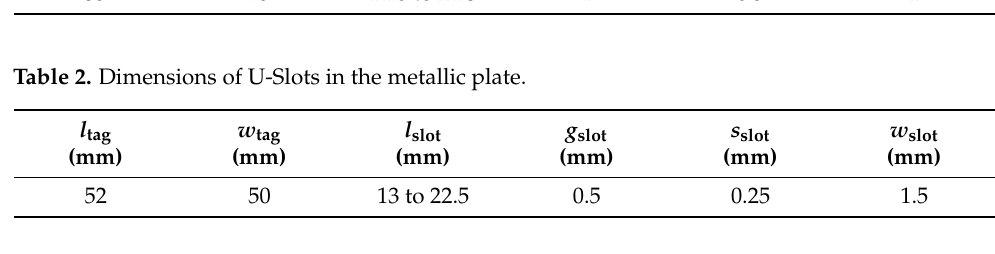
Table 3. Dimensions of dipoles over metallic plate.